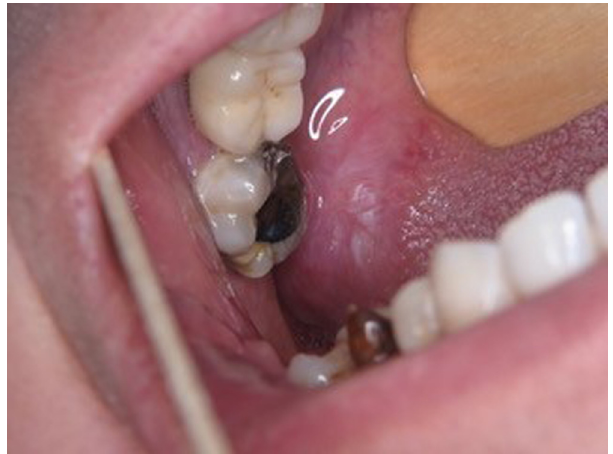
Fig. 7. Oral lichenoid reaction: white lichenoid striations with background erythema on the right lateral tongue opposing an amalgam restoration (image provided by University